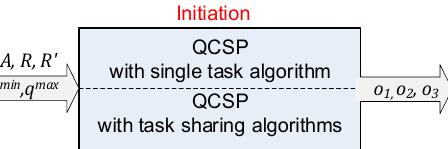
Figure 5. Three option scenarios for quay crane allocation as the output of the quay crane scheduling problem (QCSP) solution.